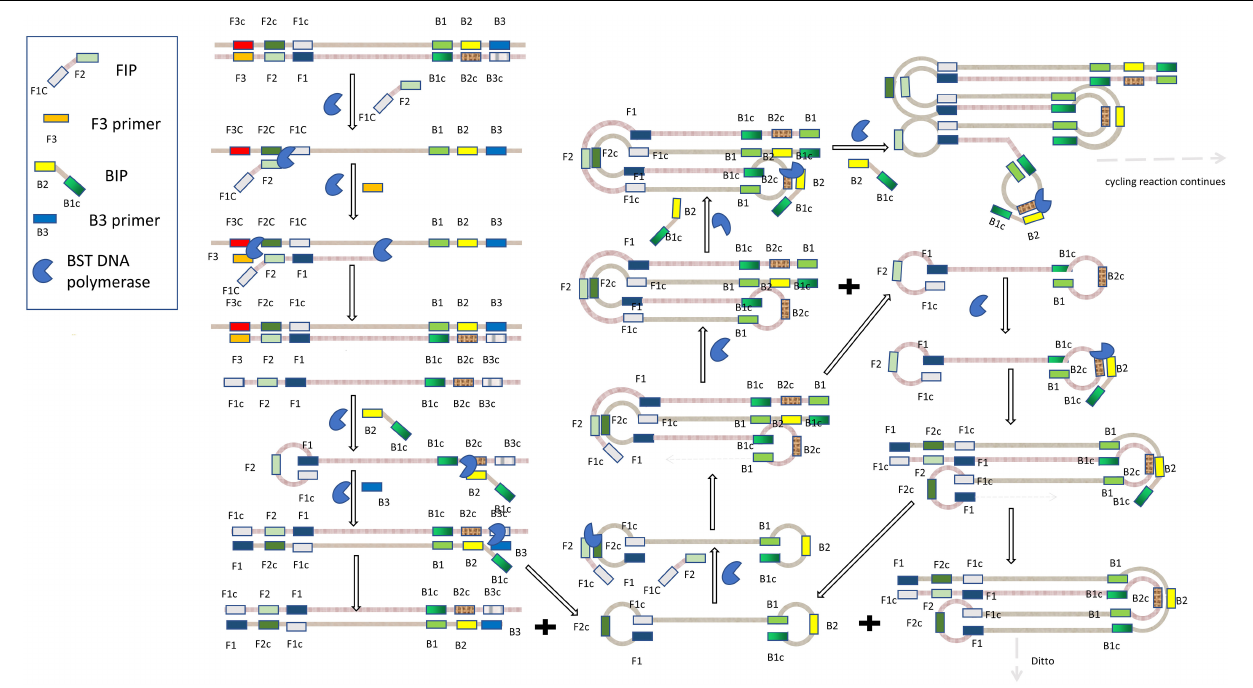
FIGURE 2 | Schematic diagram of loop-mediated isothermal